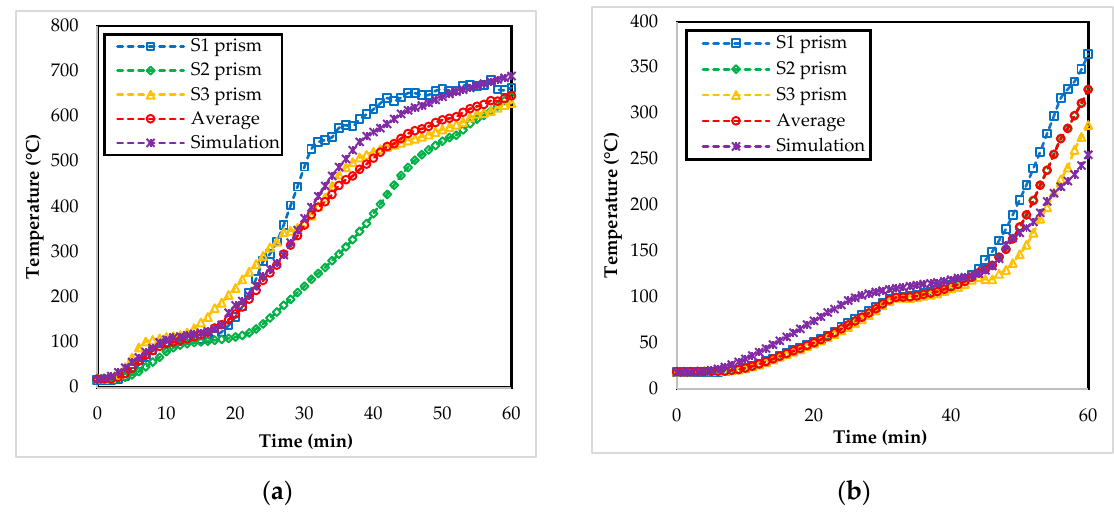
Figure 6. Temperature profile: ( a ) depth of 20 mm (prisms); ( b ) depth of 40 mm (prisms).